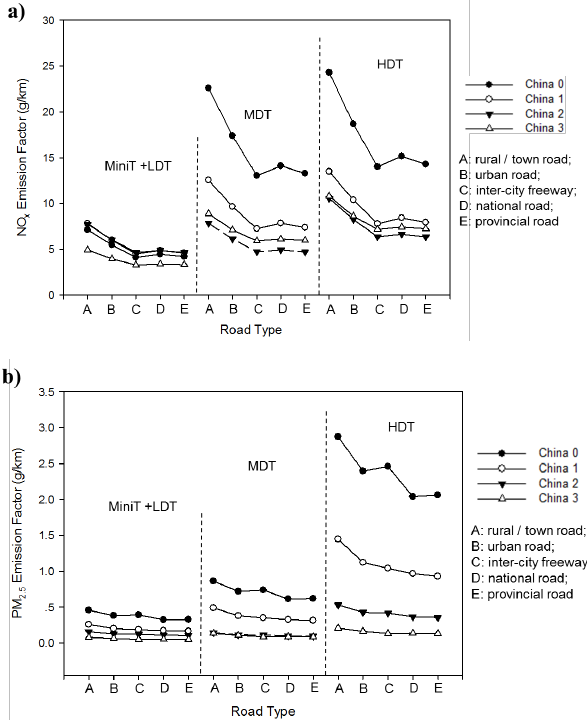
Figure 6. Emission factors on different roads: (a) NO x emission factors and (b) PM 2 . 5 emission